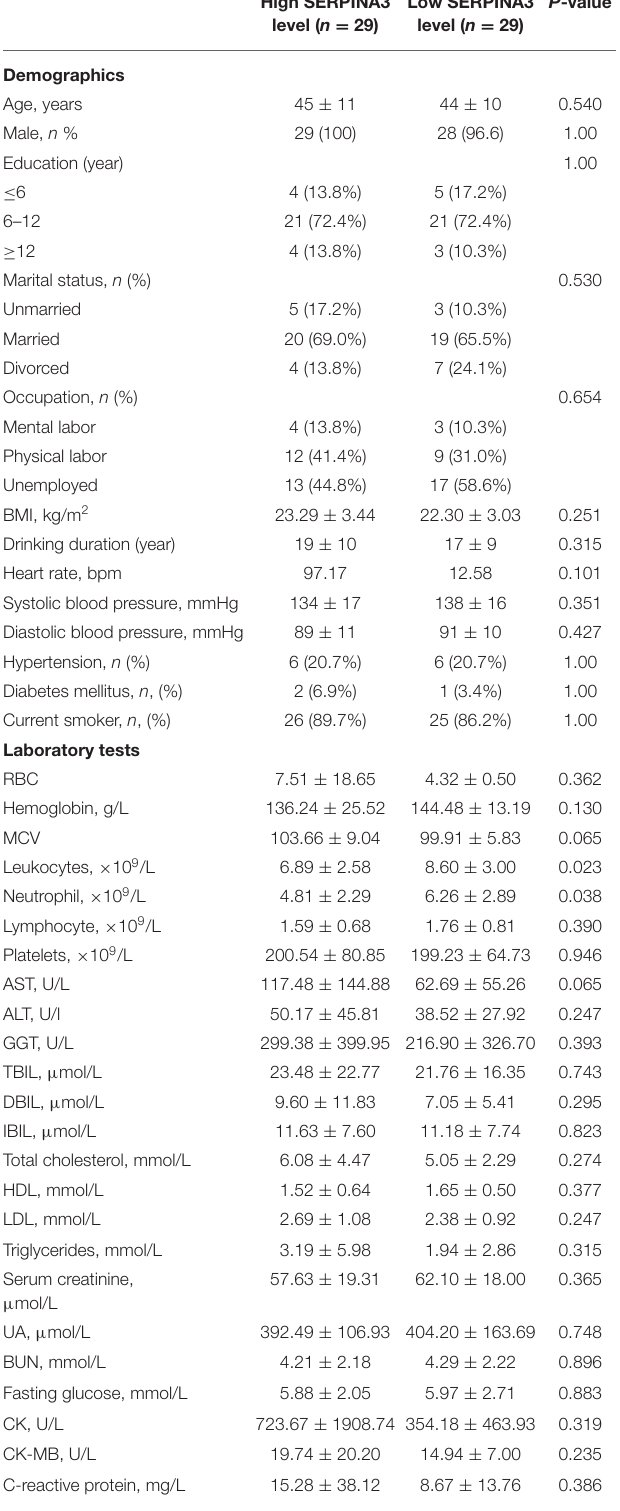
P -value High SERPINA3 Low SERPINA3 level ( n = 29) level ( n = 29)